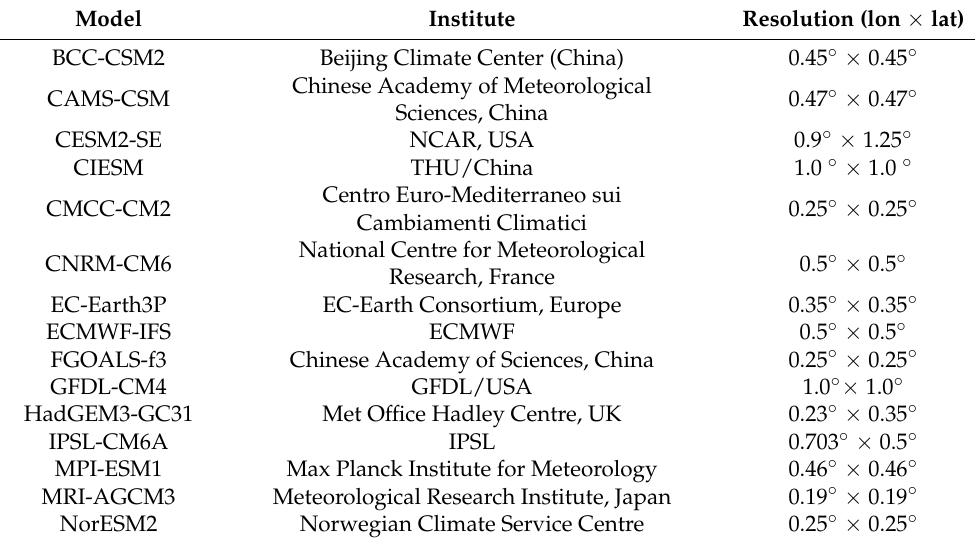
Table 1. Models registered in CMIP6 HighResMIP.